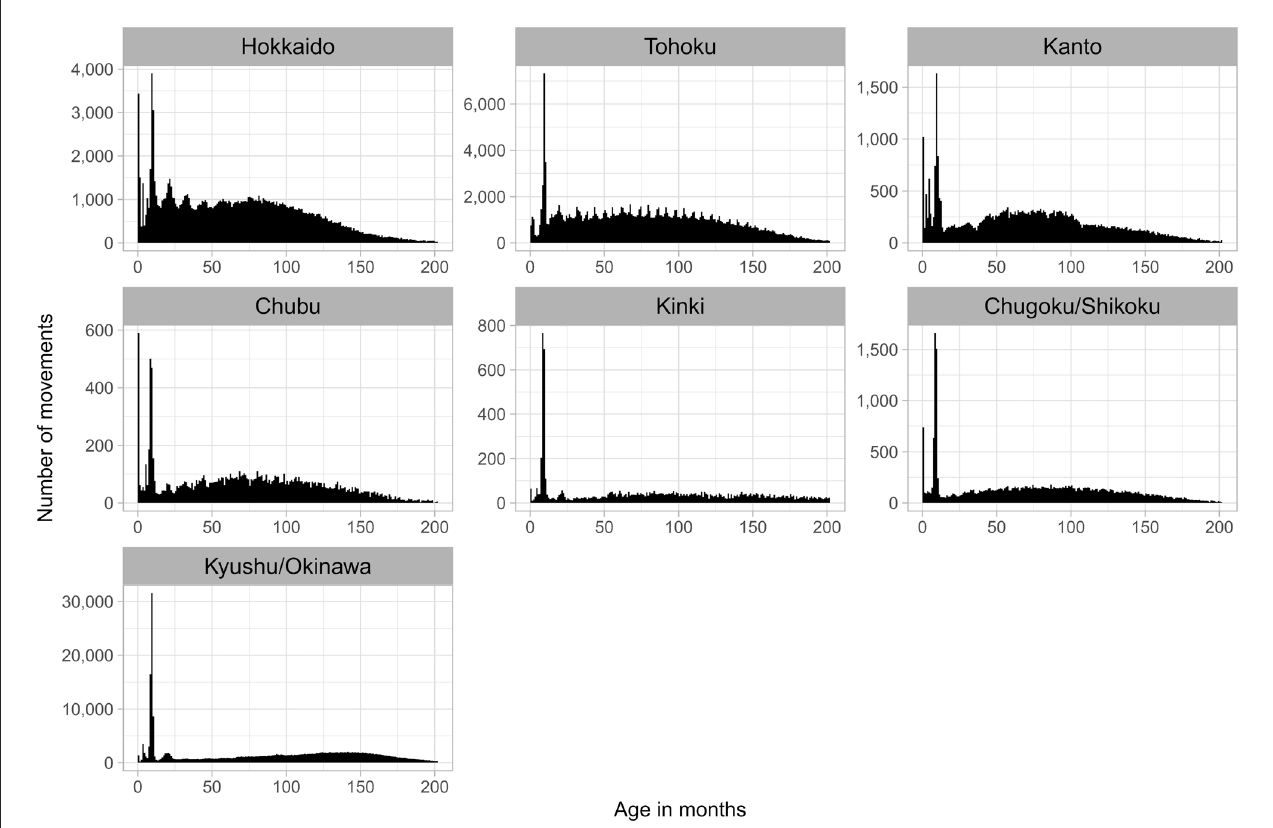
FIGURE6 Age distribution of beef cows that moved within regions in Japan from FY2012 to FY2017 by